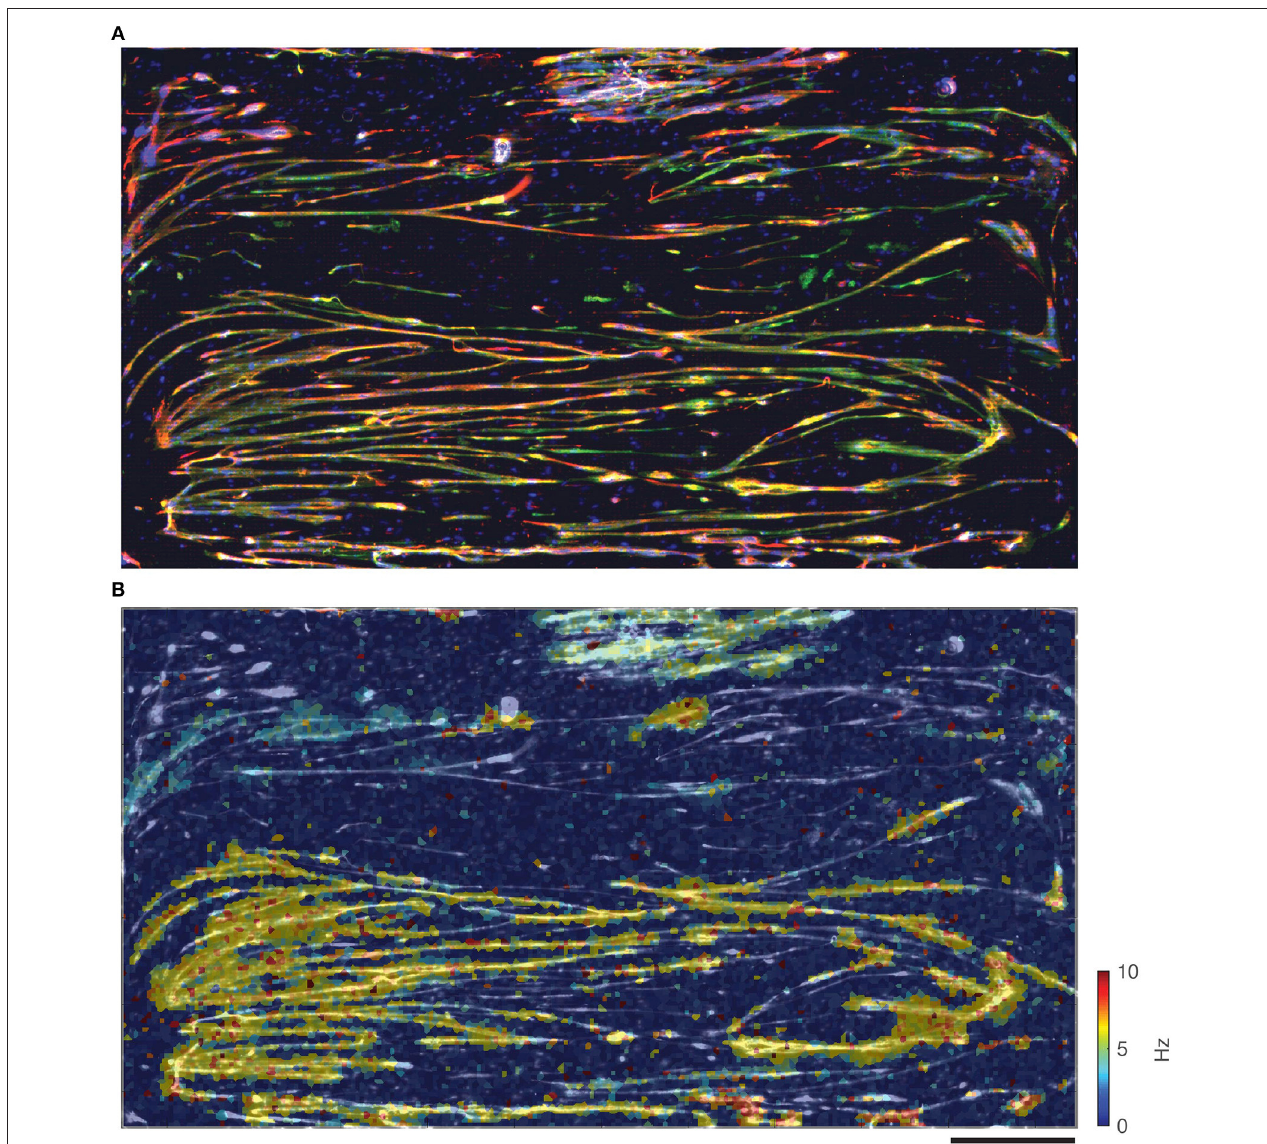
FIGURE 6 | Comparison between immunostained muscle cells and electrical spike activity. (A) Immunostained muscle cells on the electrode area stained for desmin (red), α -actinin (green), and DAPI (blue). (B) Overlay of immunostained cells (in black and white) and activity (spike frequency in color). Scale bar is 0.5mm.